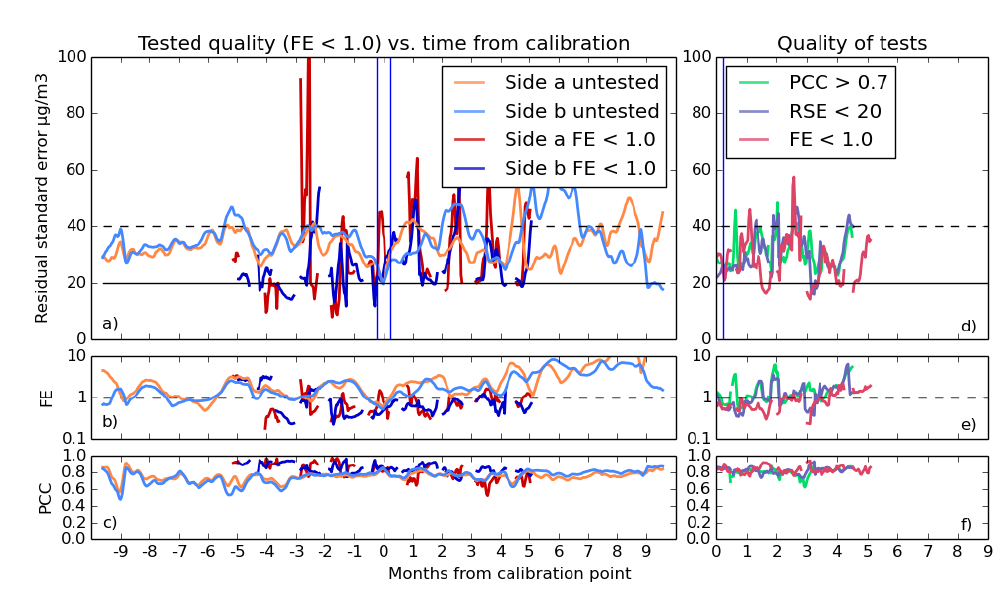
Figure 13. As for Figure 12, but with O